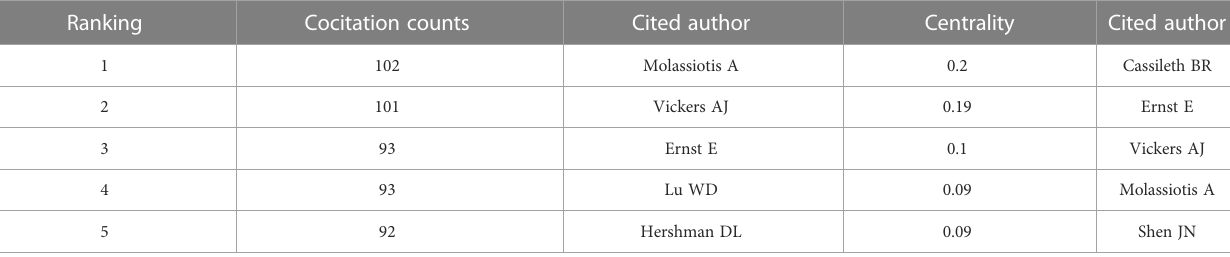
TABLE 5 Top 5 Cited authors of studies on acupuncture for cancer